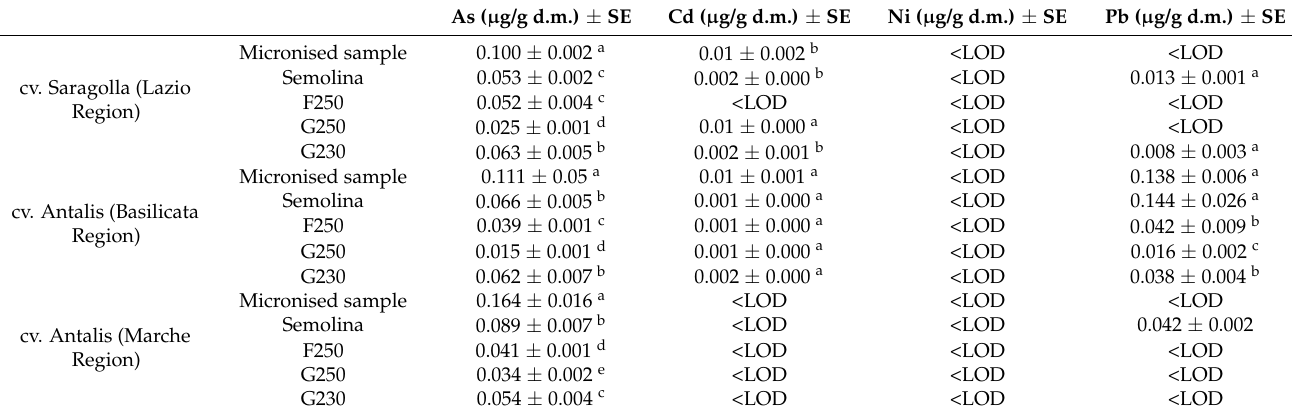
Table 3. Group II: average values ± standard error (SE) of arsenic (As), cadmium (Cd), nickel (Ni), and lead (Pb) contents in the micronised, semolina, and selected air-classified fractions (F250, G250, and G230); d.m.: dry matter; LOD: limit of detection, different letters indicate significant difference ( p < 0.05 ), n =